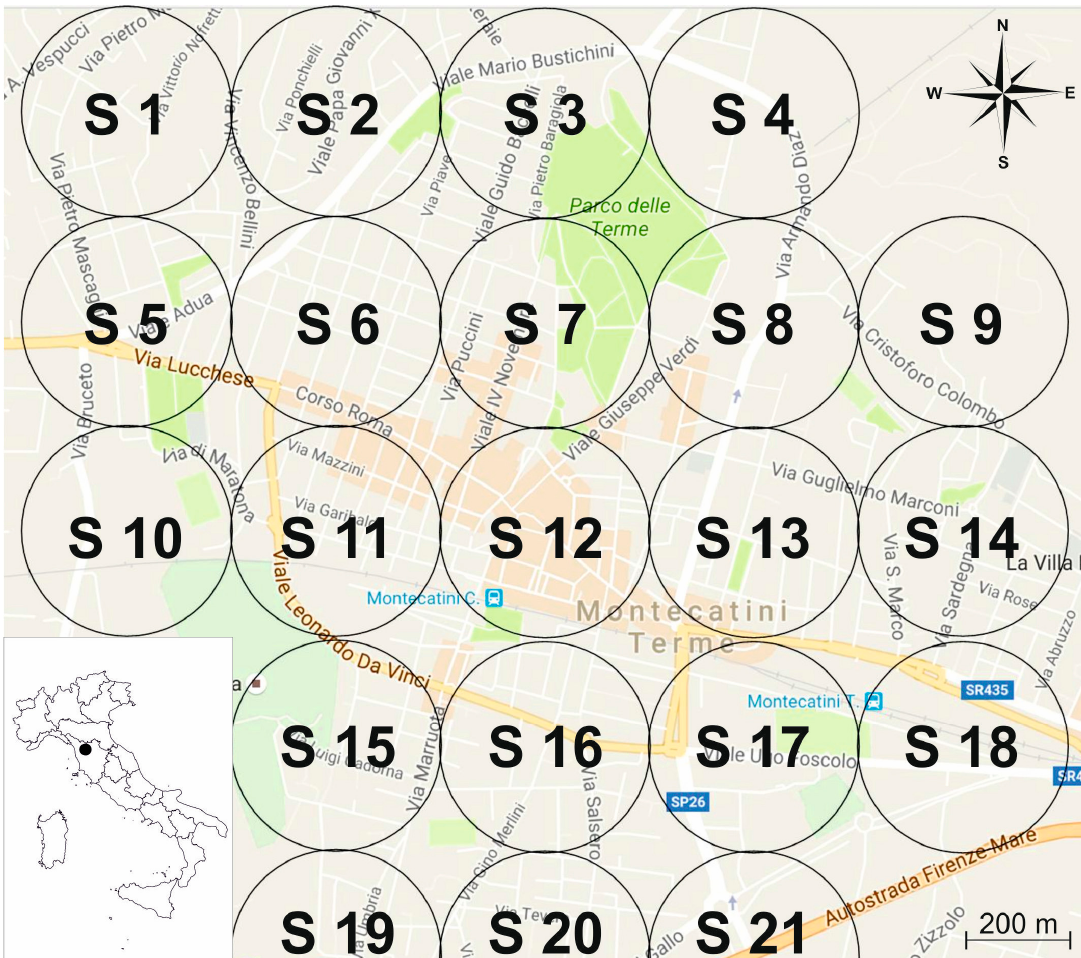
Figure 1. Map of the study area with indication of the sampling